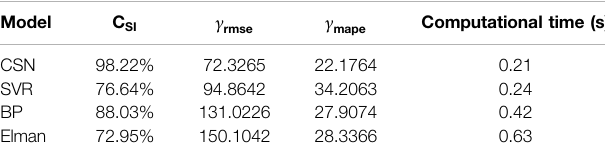
TABLE 4 | Prediction evaluation of ramping